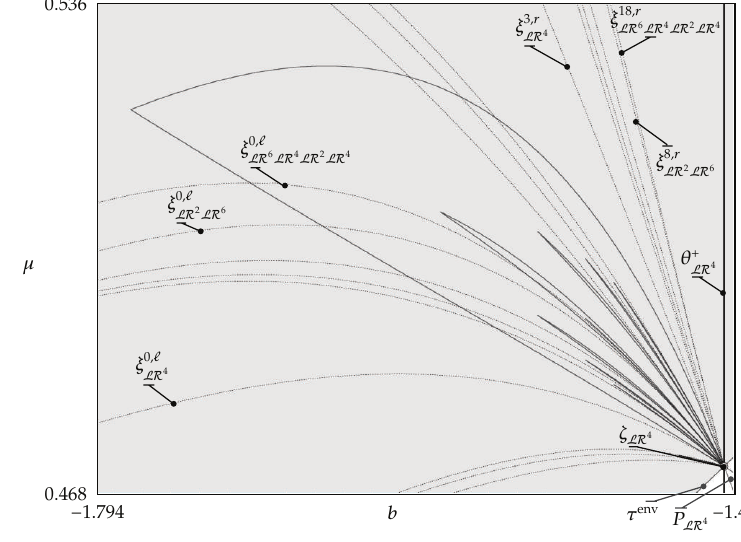
Figure 11: Analytically calculated bifurcation structure close to the big bang bifurcation point ζ LR 4 . Solid curves (cid:7) except the boundary curve τ env and the stability boundary θ (cid:5) LR bifurcation curves, dashed curves—to the border collision bifurcation curved. For more details see text. The numerical Figure 10 corresponds to this image.